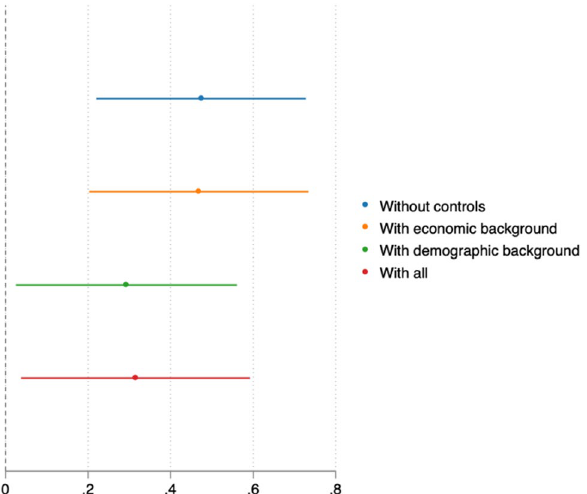
Figure 4. The association between being a conservative voter and being vaccinated. This figure plots the coefficients capturing the relationship between being a Conservative voter and vaccination status based on logistic regressions using five waves of a YouGov survey conducted between the 4th of October and the 9th of November, 2021. It adds controls for socio-economic background (number of children and social class), demographic characteristics (age, gender) and region fixed effects. The 95% confidence interval is calculated using robust standard errors. The sample size is 5967 observations when all controls are